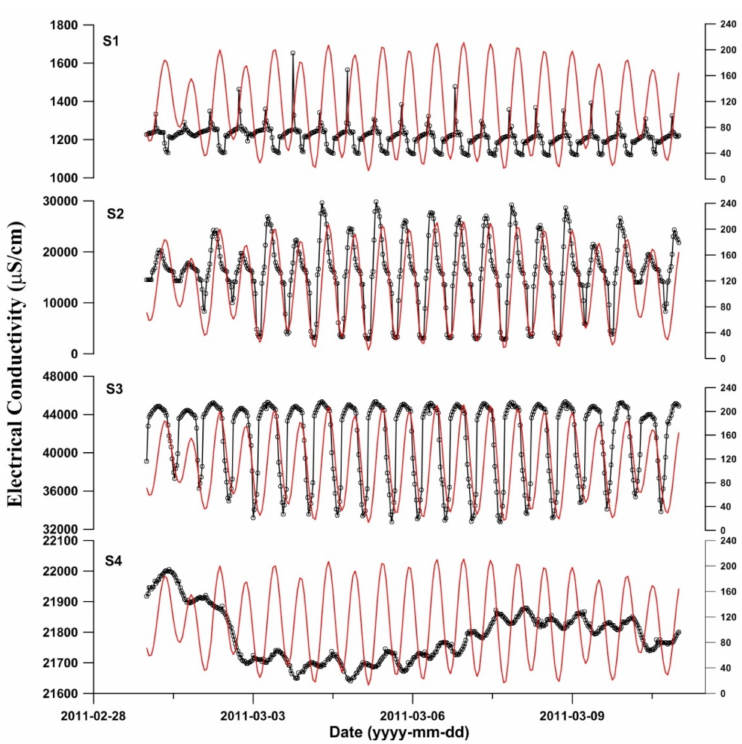
Figure 7. EC (black line) and ocean tide (red line) at S1, S2, S3, and S4 depths in well SS-1.